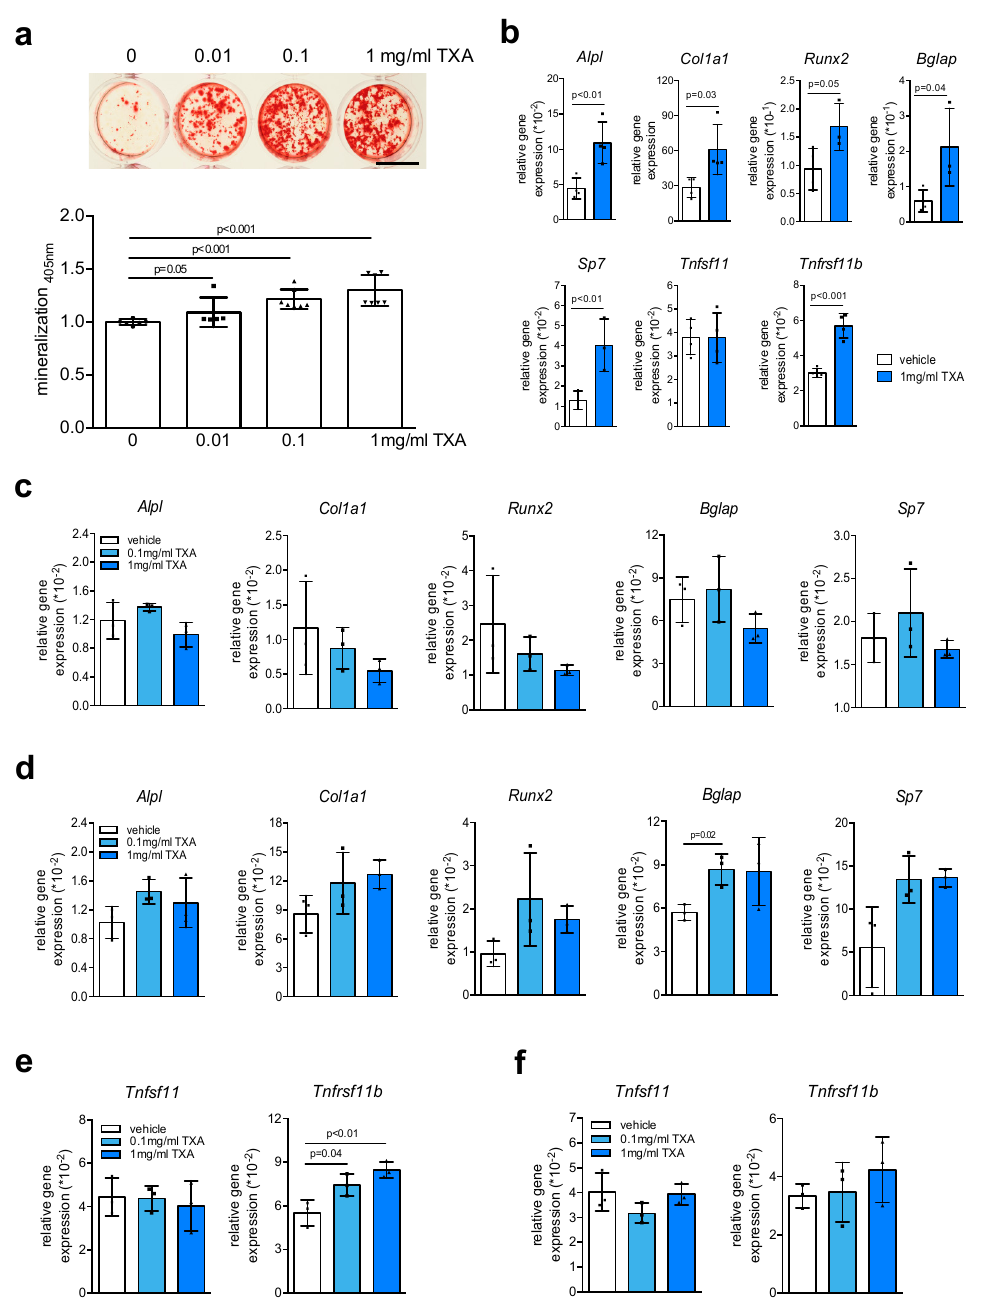
Figure 2. TXA promotes extracellular matrix mineralization. ( a ) Representative alizarin red stainings of bone marrow- derived osteoblasts from WT mice differentiated in the presence of indicated concentrations of TXA for 10 days in osteogenic medium. Scale bar 10 mm. The quantification of extracellular matrix mineralization is indicated below. ( b ) qRT-PCR expression analysis for the indicated genes in bone marrow-derived osteoblasts at day 10 of osteogenic differentiation, stimulated with TXA (1 mg/mL) during the entire course of cell differentiation. ( c , d ) qRT-PCR expression analysis for the indicated genes in bone marrow-derived osteoblasts at day 2 ( c ) and day 10 ( d ) of osteogenic differentiation, stimulated with TXA for 6 h at the indicated concentrations after serum starvation overnight. ( e ) qRT-PCR expression analysis for the indicated genes in the same cells at day 2 or ( f ) day 10 of differentiation. For ( a – f ), n = 3–4 independent cultures per group were used. Data presented are means ± SD. Gene abbreviations: runt-related transcription factor 2 ( Runx2 ), osterix ( Sp7 ), alkaline phosphatase ( Alpl ), alpha-1 type I collagen ( Col1a1 ), osteocalcin ( Bglap ), sclerostin ( Sost ), Rankl ( Tnfsf11 ), osteoprotegerin ( Tnfrsf11b